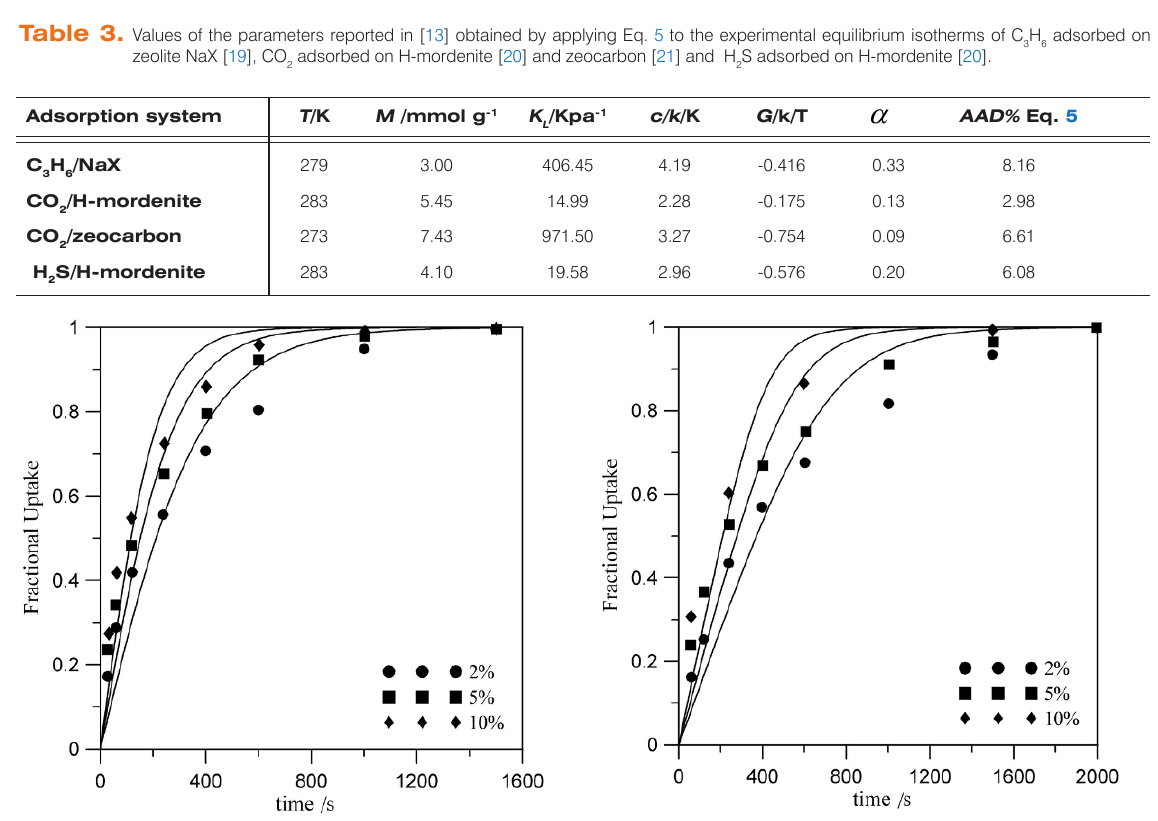
Figure 5. Comparison of the experimental kinetic isotherms for the C H /Ajax AC adsorption at 303 K measured 2 6 by Qiao and Hu [15] with the theoretical isotherms (solid lines) calculated from Eq. 10 by accepting the values of parameters collected in Table 2. The values of parameters a and b as well as error function corresponding to fits quality are collected in the last three columns of Table 2.